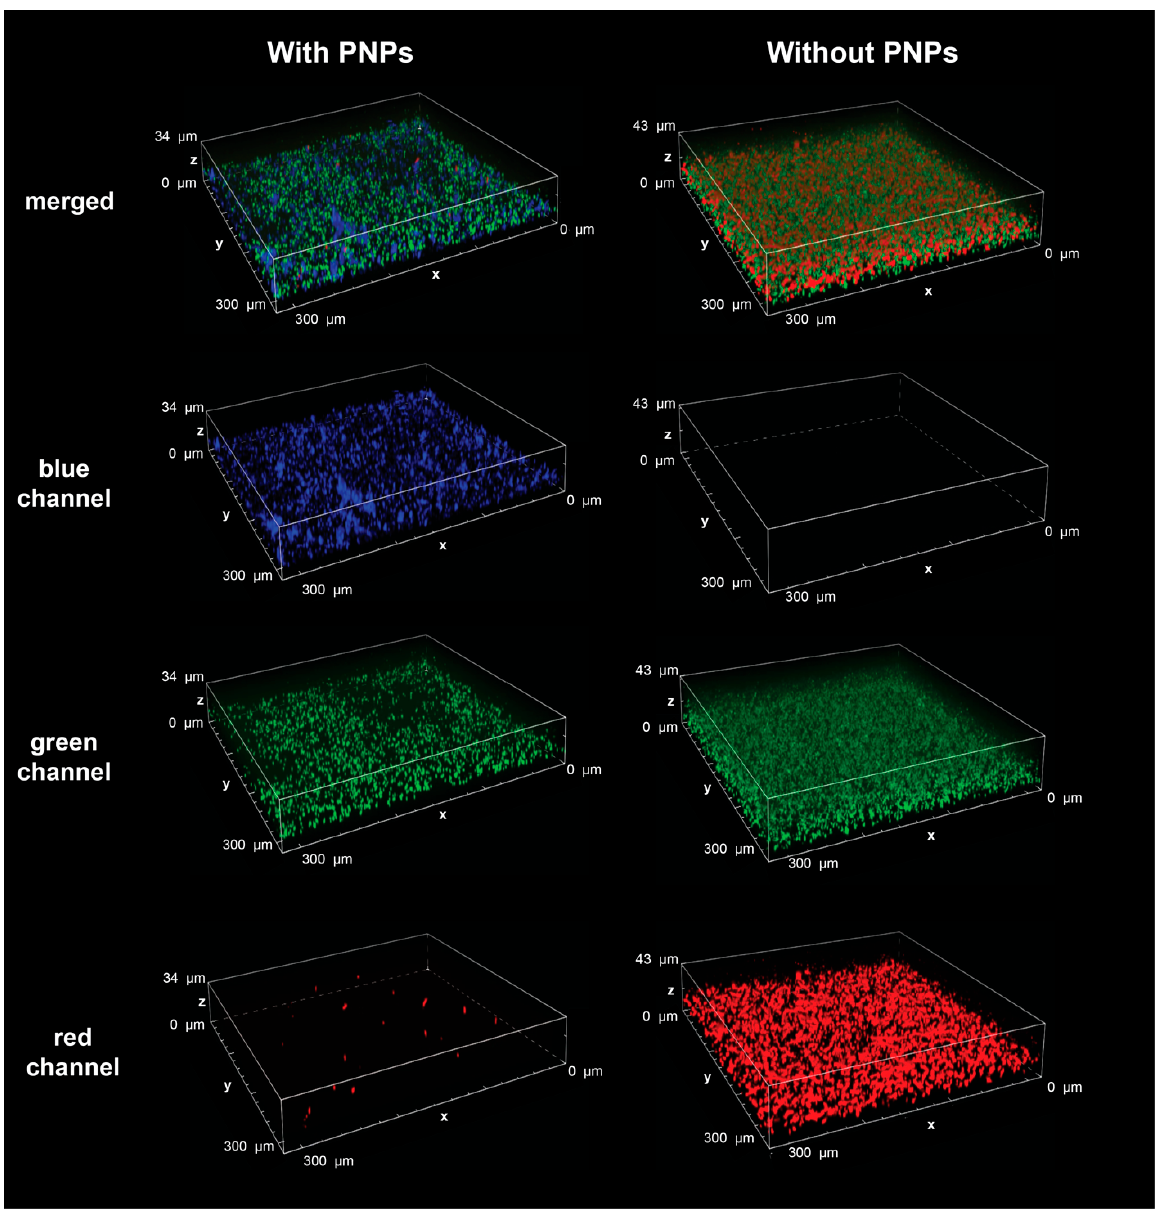
Figure 1. Representative 3D views of confocal image stacks of 4-day-old dual-species biofilm of DsRed-expressing E. coli (red channel) and GFP-expressing MRSA (green channel), coumarin blue-tagged PNPs (blue channel) and their overlay after treating the biofilms for 1 h with 1 μ M coumarin blue-tagged PNPs in M9 media.